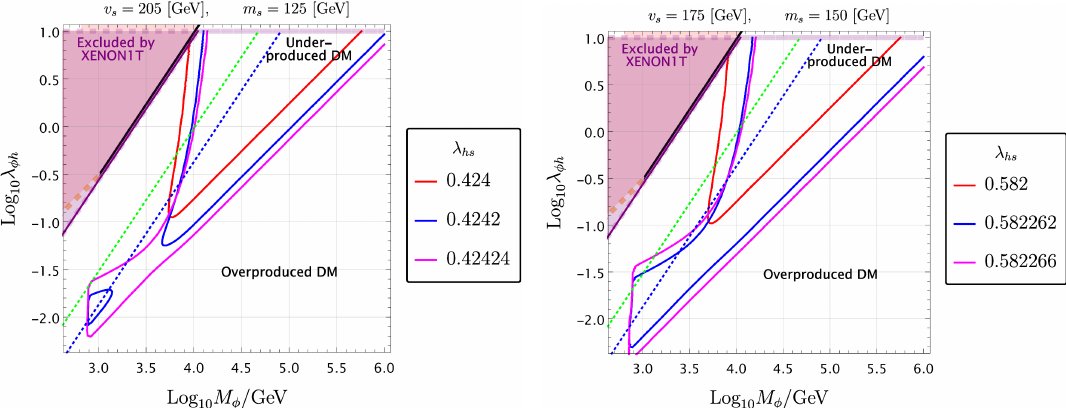
Figure 6 . Left : dM abundance in the parameter space λ φh − M φ for different values of λ hs by fixing v s = 205 GeV and m s = 125 GeV (that fixes the values of T nuc , T reh and γ terminal lines represent correct DM abundance, while underproduced inside and overproduced outside. The lower part of each contour is dominated by freeze-out and the upper part via bubble expansion. The connecting vertical line (independent of the portal) comes from thermal production after the reheating of the transition. The magenta shaded region is excluded by XENON1T while the dotted green and blue lines are projected limits from XENONnT and DARWIN respectively. Right : same plot for v s = 175 GeV and m s = 150 GeV. As expected, increasing the tuning from red to magenta increases the amplitude of the curve. The values used are extracted from table